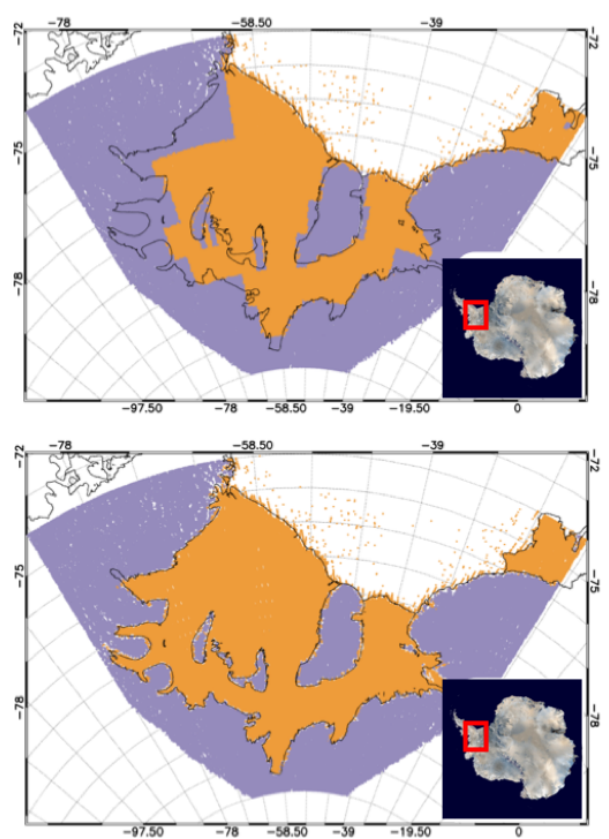
Figure 2. Surface-type mask shown for the Filchner–Ronne ice shelf area (ice shelf in orange, ice sheet in blue). Upper panel: Baseline-C; lower panel: Baseline-D. Map data ©NASA/Dave